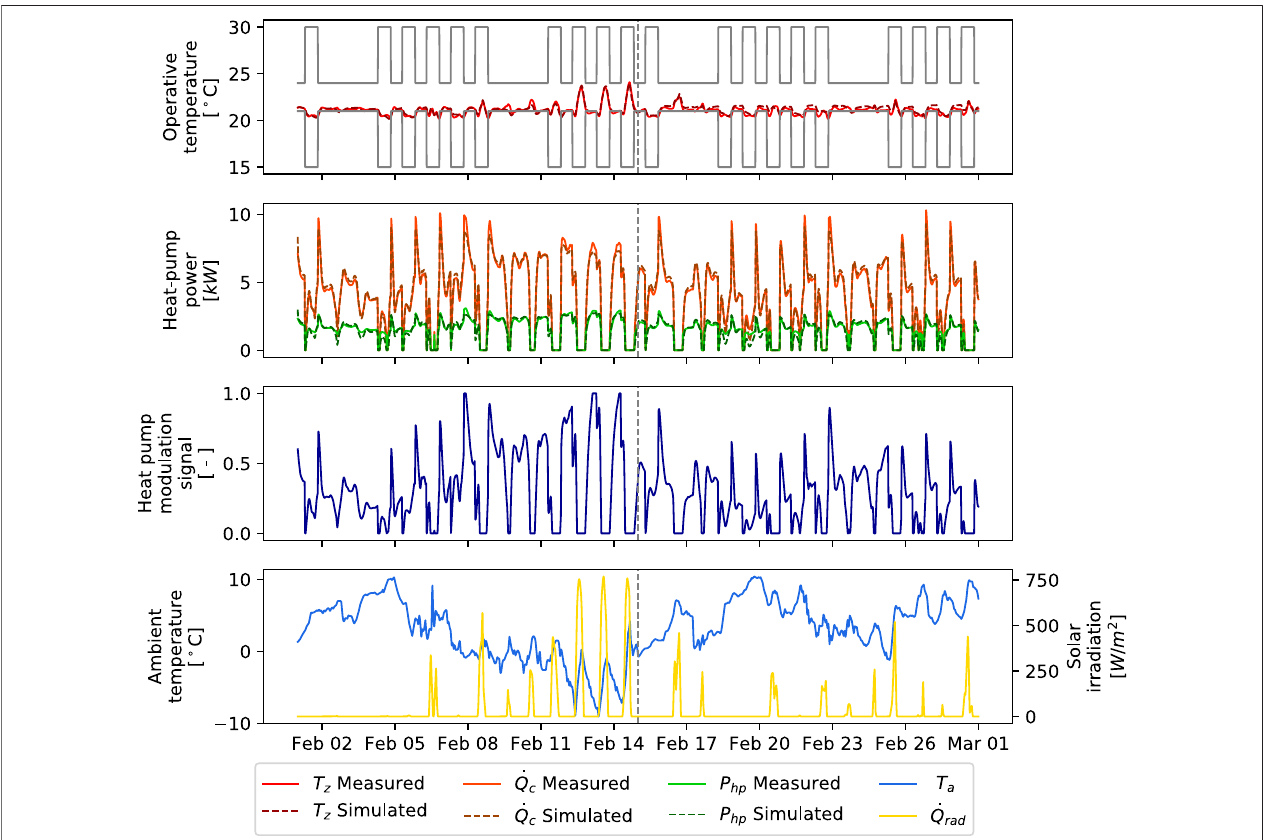
FIGURE 4 | Training and validation periods for estimating the controller model F . The training period is at the left of the vertical grey dashed line and the validation periodattheright.Theinputsarepresentedinthebottomtwoplots,andthesimulatedoutputsarepresentedinthetoptwoplotsandcomparedwiththemeasureddata. The grey lines in the fi rst plot represent the comfort